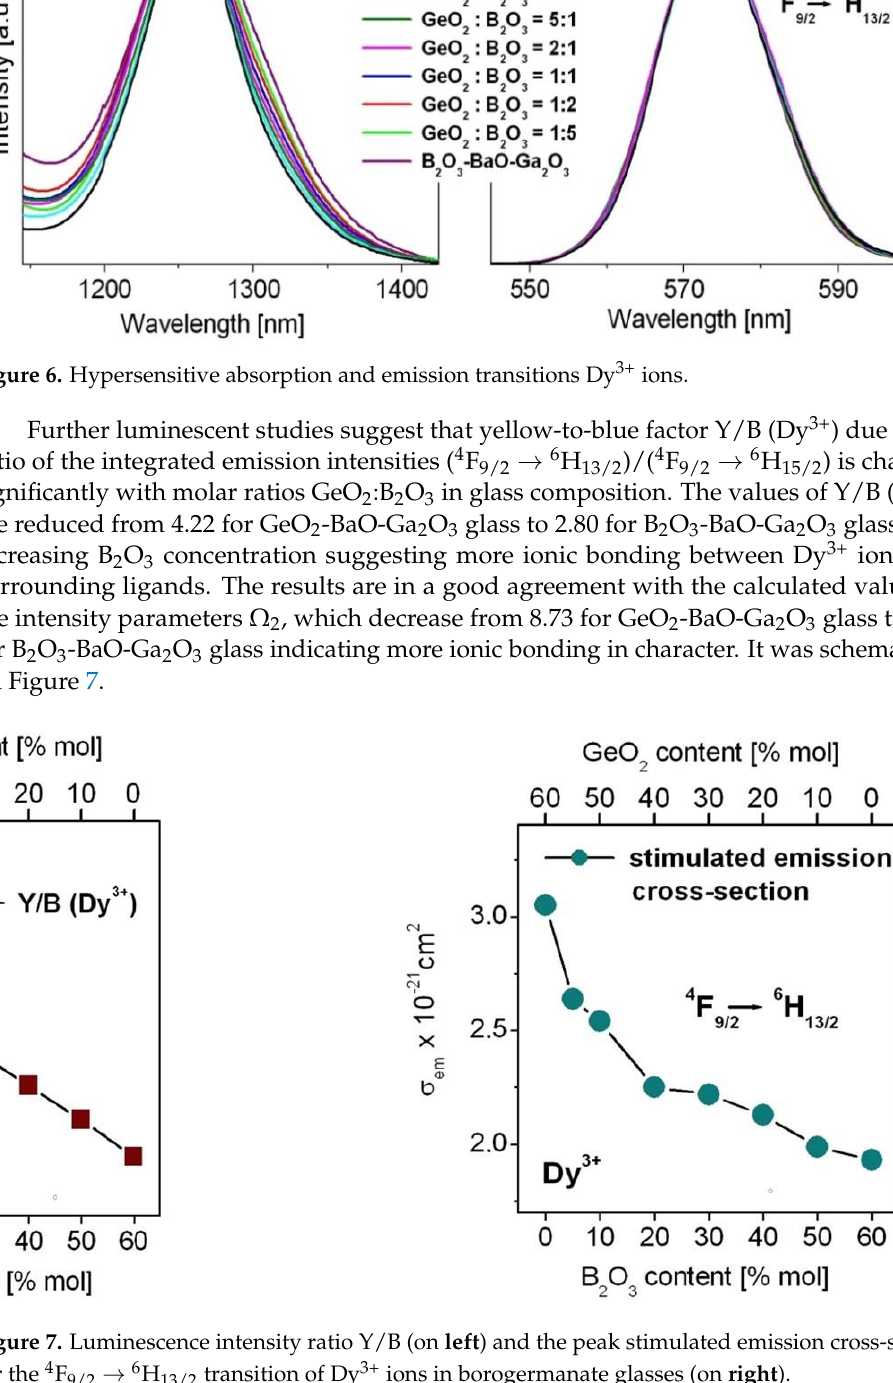
Figure 6. Hypersensitive absorption and emission transitions Dy 3+ ions.